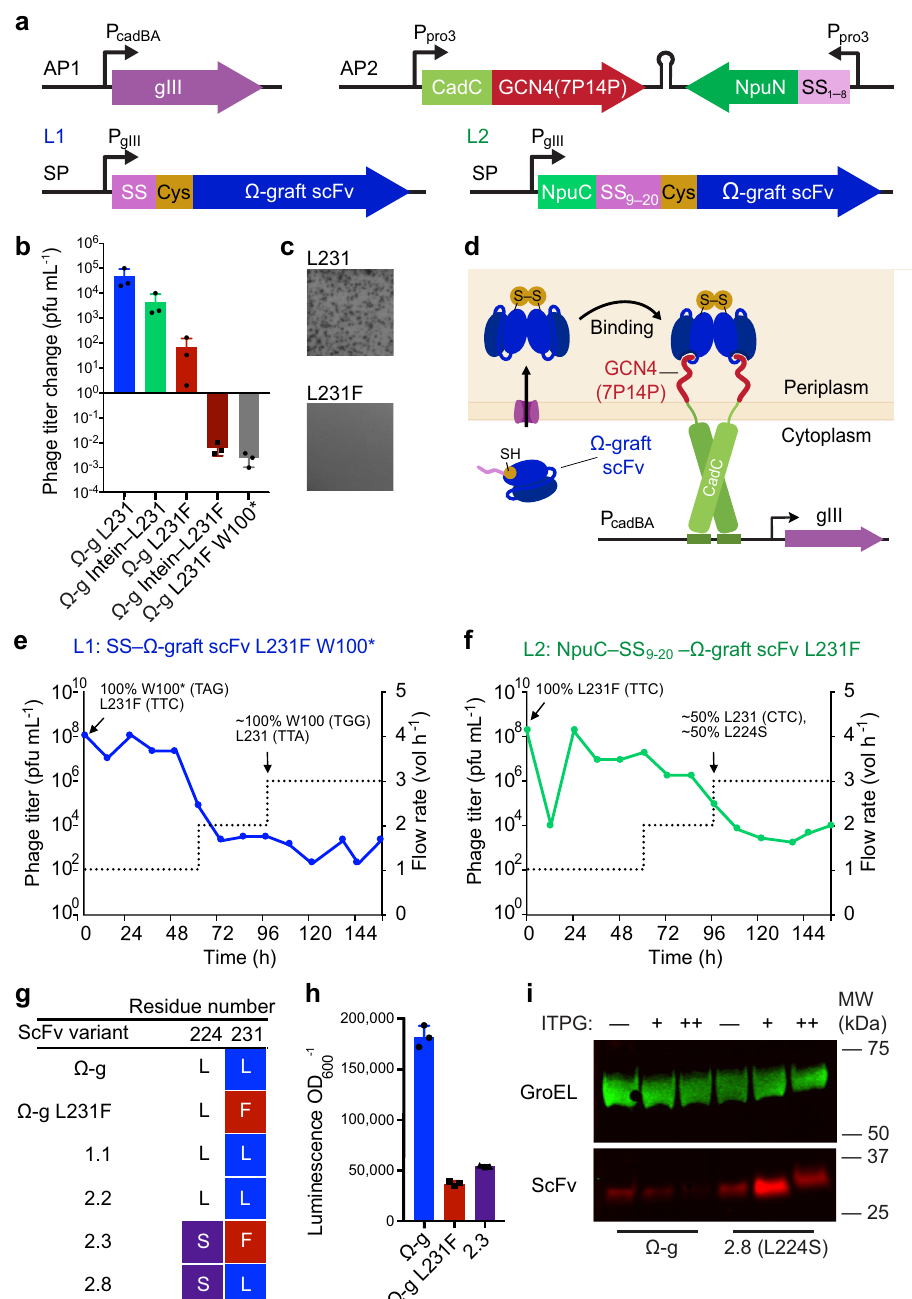
Fig. 4 Second-generation pPACE selection reverts a binding mutant in Ω -graft scFv. a Schematic of periplasmic PACE architecture 2 components. Ω -graft ( Ω -g) scFvs form covalent dimers through N-terminal cysteine residues. GCN4 monomeric variant 7P14P is used to avoid background dimerization of